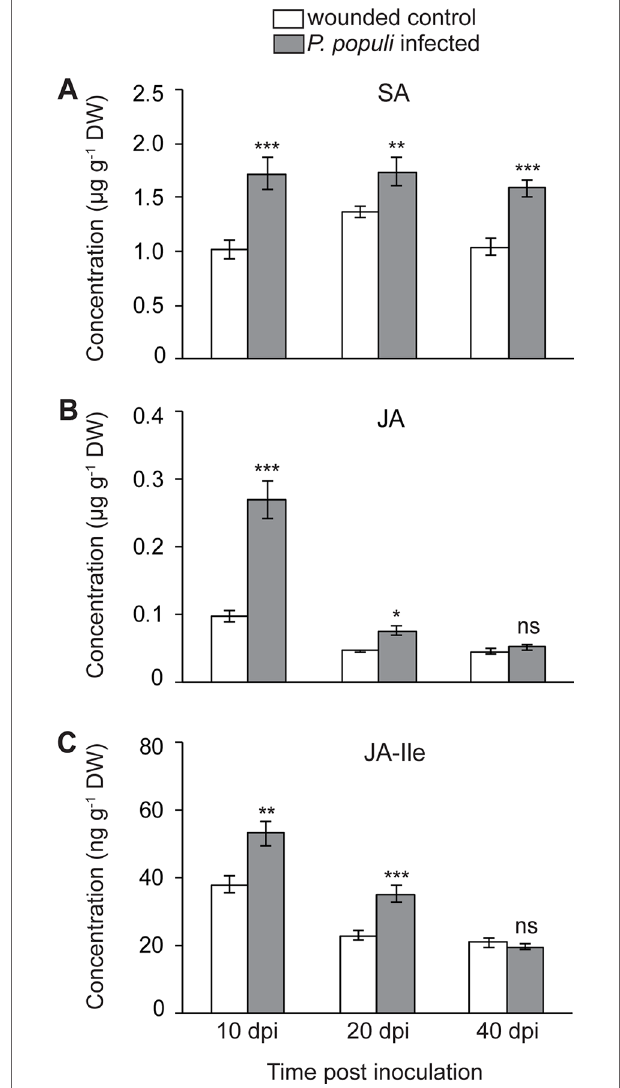
FIgURe 5 | Concentrations of (A) salicylic acid (SA), (B) jasmonic acid (JA), and (C) JA-isoleucine (JA-Ile) in black poplar stems increase after P. populi infection. Trees approximately 1 m in height were inoculated with P. populi after wounding and control trees were inoculated with sterile culture medium. Analysis was performed by LC-tandem mass spectrometry. Samples were harvested from separate trees at each time point. Data were analyzed using Student’s t-test (*, p ≤ 0.05; **, p < 0.01; and ***, p < 0.001; ns, non- significant). Data represented in figures are mean ± SE (n = 5). dpi, days post inoculation; DW, dry